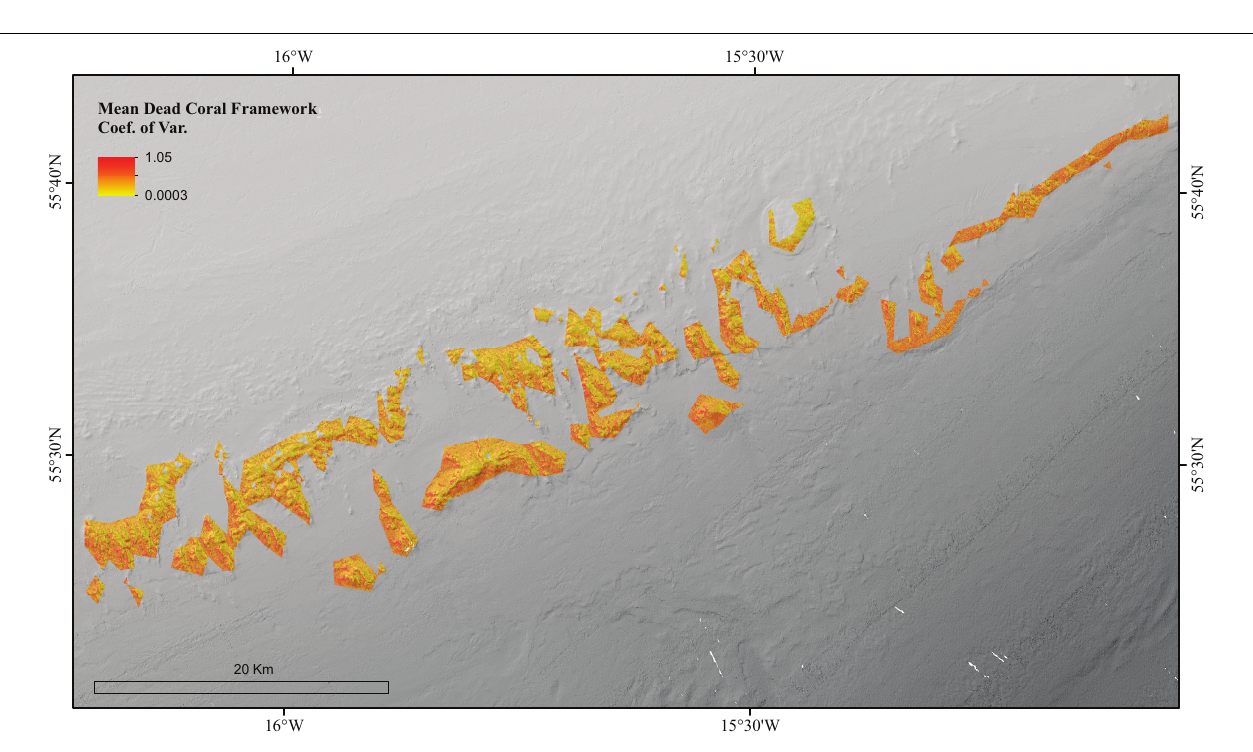
Frontiers in Marine Science |